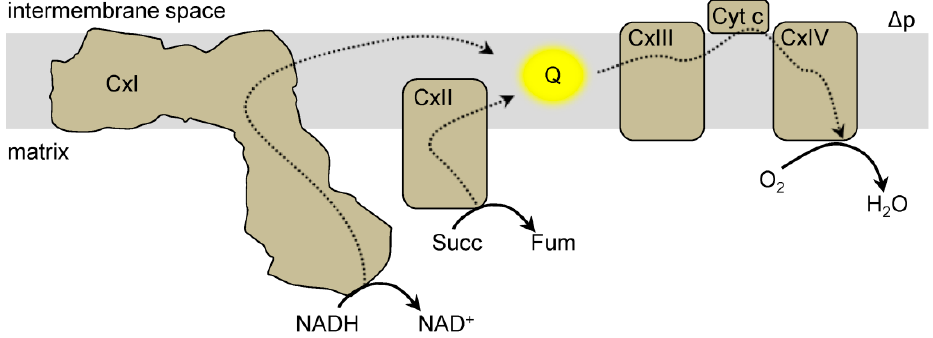
Figure 1. Mitochondrial electron transport chain. The electron transport chain (ETC) is located in the mitochondrial inner membrane. Electrons (dashed lines) from reducing equivalents (e.g., NADH) enter the ETC at complex I (CxI) or complex II (CxII) and reduce the ubiquinone pool (Q, yellow). Electrons are then transferred from QH 2 to complex III (CxIII), to cytochrome c (Cyt c) and ultimately onto oxygen (O 2 ) at complex IV (CxIV). During this process protons are pumped (not shown) to generate a protonmotive force ( Δ p) which is comprised of a membrane potential and a proton concentration gradient.